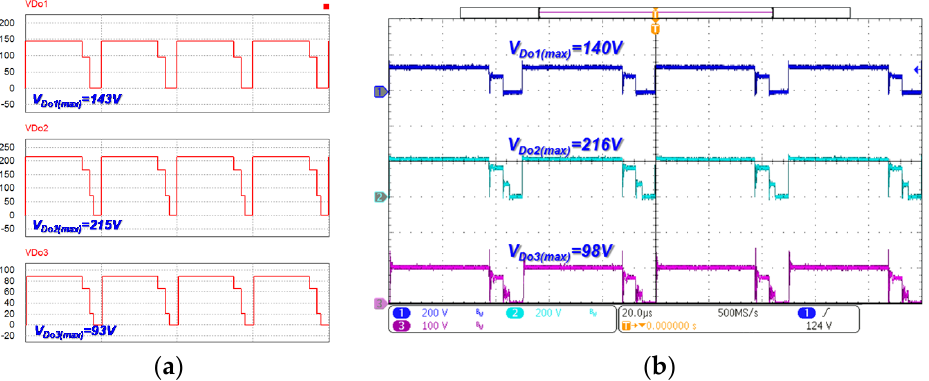
Figure 13. Switch voltage waveforms in the battery charging mode: ( a ) by simulation; and ( b ) by measurement. Energies 2016 , 9 , 180